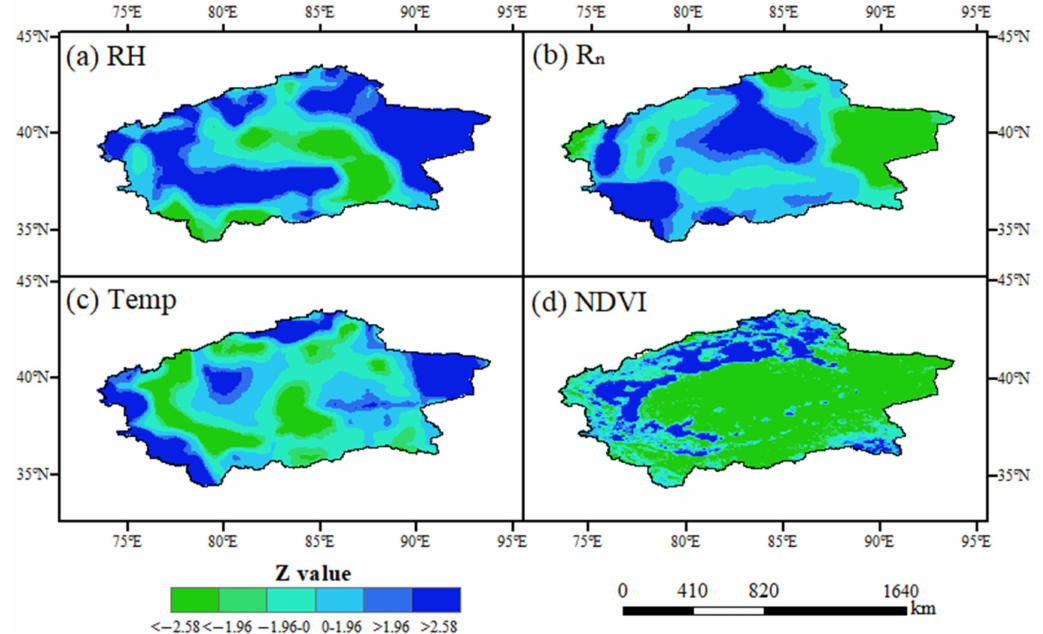
Figure 7. The M-K Test Z value of Temp, Rn, RH, and the NDVI in southern Xinjiang from 1982 to 2015. ( a–d ) describe the Z value of relative humidity, net radiation, temperature and NDVI, respectively. We used four environmental factors as input parameters, and monthly ET values were used as output. The mean decrease accuracy value was used to determine the importance of each factor by the Random forest model. Figure 8 showed the statistical results of ET values for six land-use types, as affected by four meteorological environmental